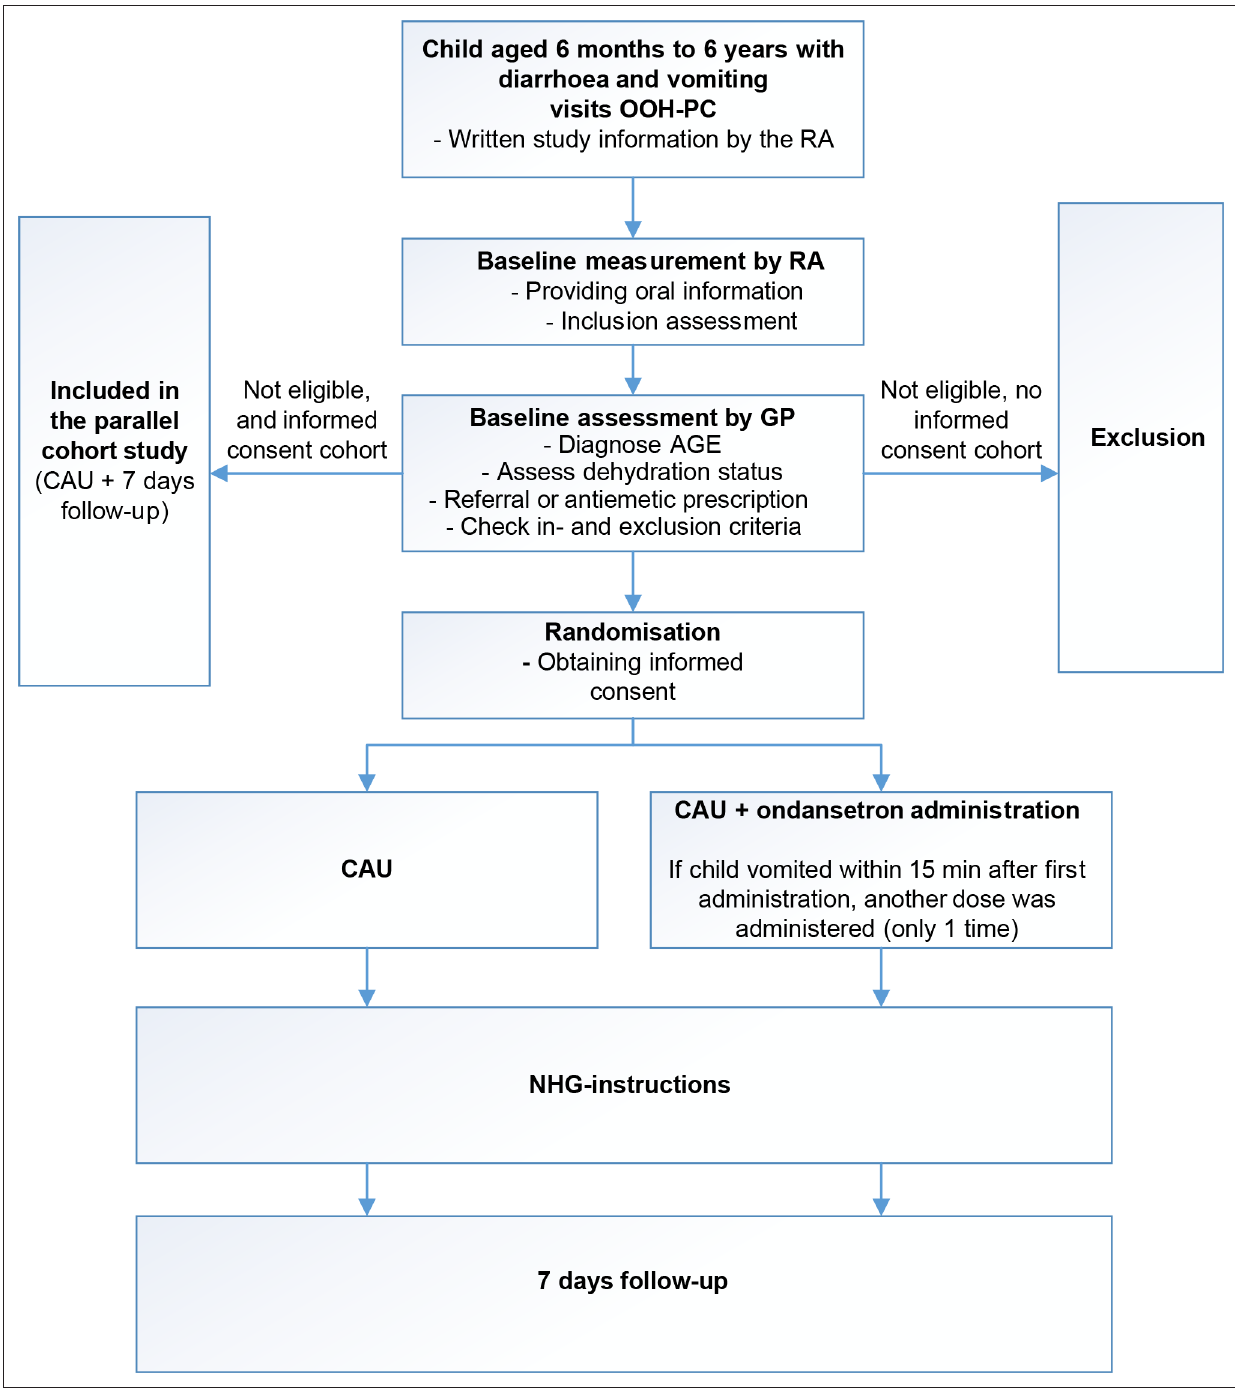
Figure 1 Study design. AGE = acute gastroenteritis. CAU = care as usual. OOH- PC = out- of- hours primary care. RA = research